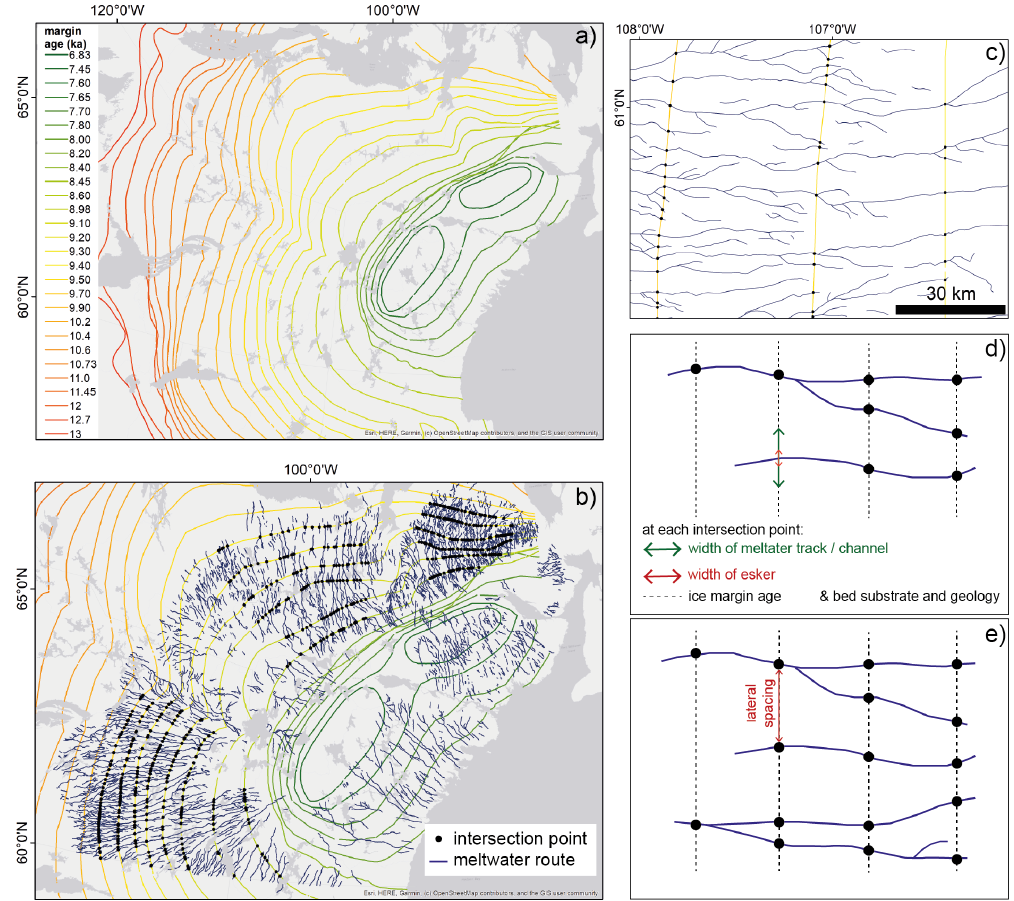
Figure 4. (a) Ice-margin estimates (Dyke et al., 2003) for the Keewatin sector of the LIS; (b) intersection points between mapped meltwater routes and ice-margin estimates used for sample locations; (c) a zoomed-in example of meltwater routes, margin isochrones and intersections from the SW of the study area; (d) method for recording meltwater route characteristics; and (e) lateral